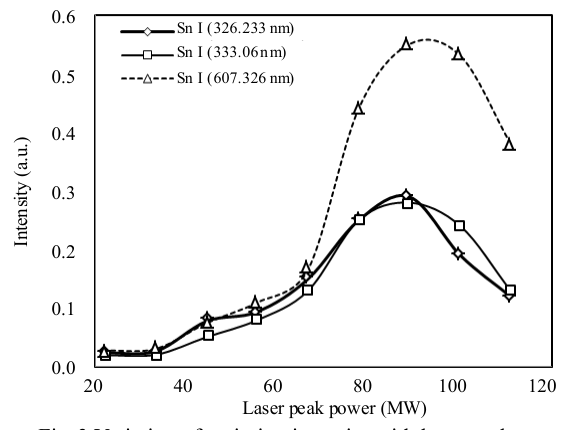
Fig. 3 Variation of emission intensity with laser peak power.